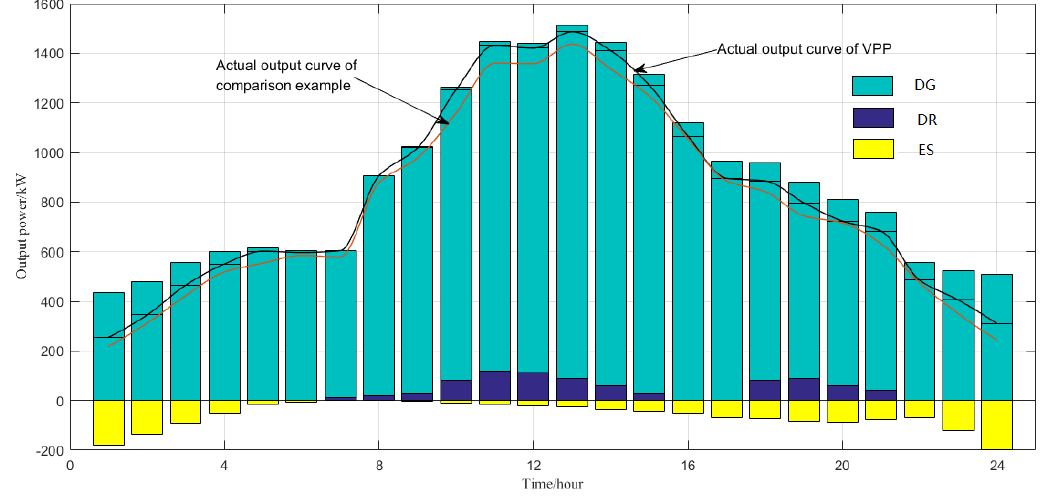
Figure 11. Output curve of VPP.